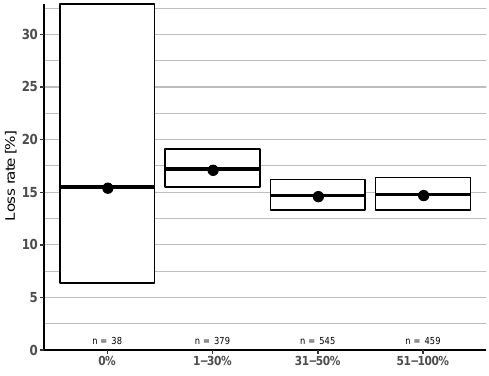
Figure 7. Comparison between relative amount of exchange rate of old brood frames in four given percentage groups and corresponding winter honey bee colony loss rates (and 95% CI).